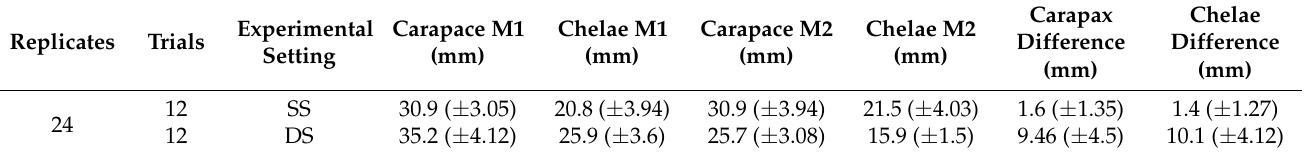
Table 1. Average ( ± SD) of chelae length and carapaces width of male crabs (M1 and M2) involved for 12 trials for Same Sized (SS) and Different Sized (DS) experimental setting and their differences. Experimental Replicates Trials